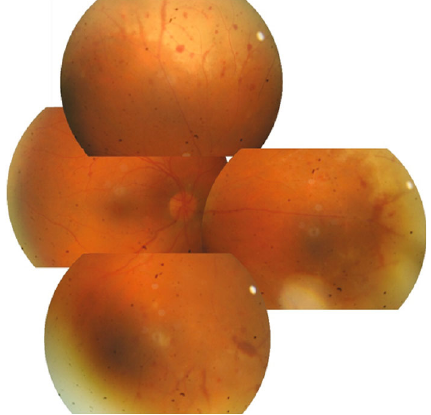
Figure 1: Montage of retinal photographs (Canon 60UVi, Tokyo, Japan) showing vitritis, areas of retinitis, retinal vasculitis, retinal hemorrhage, and hyperemia and edema in the head of the optic nerve at initial presentation examination.